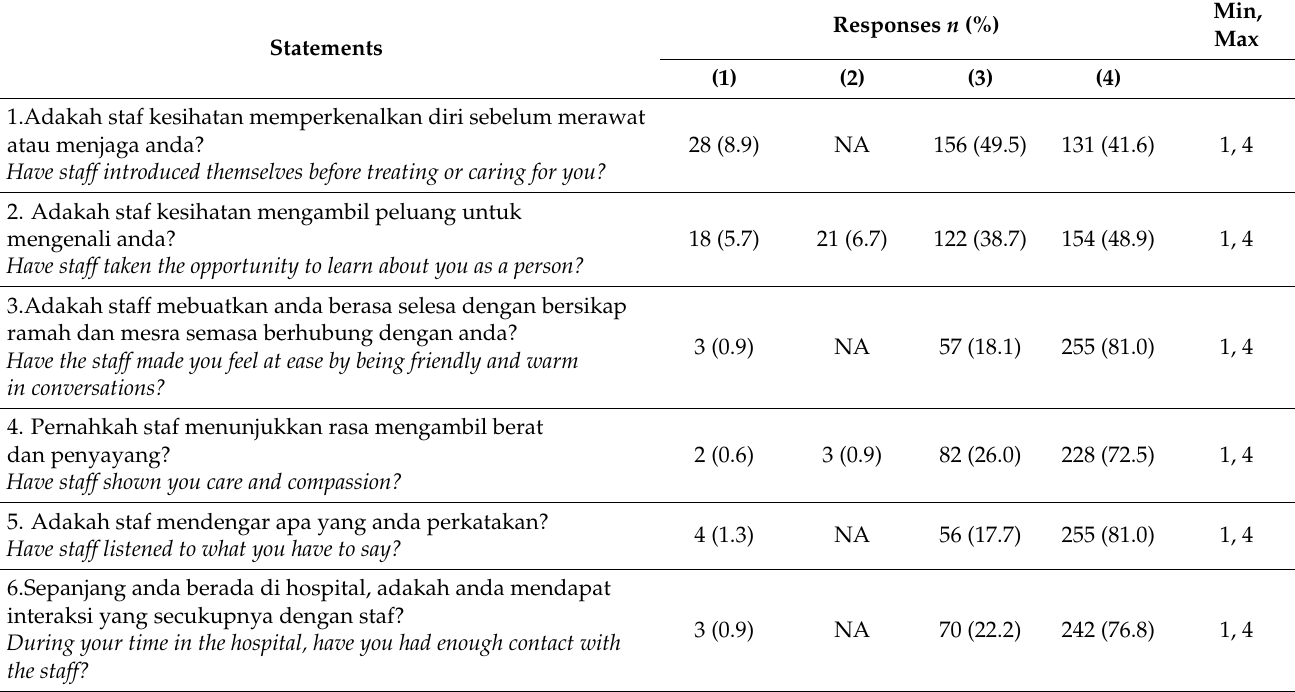
Table 4. Responses to each item in the questionnaire ( n =